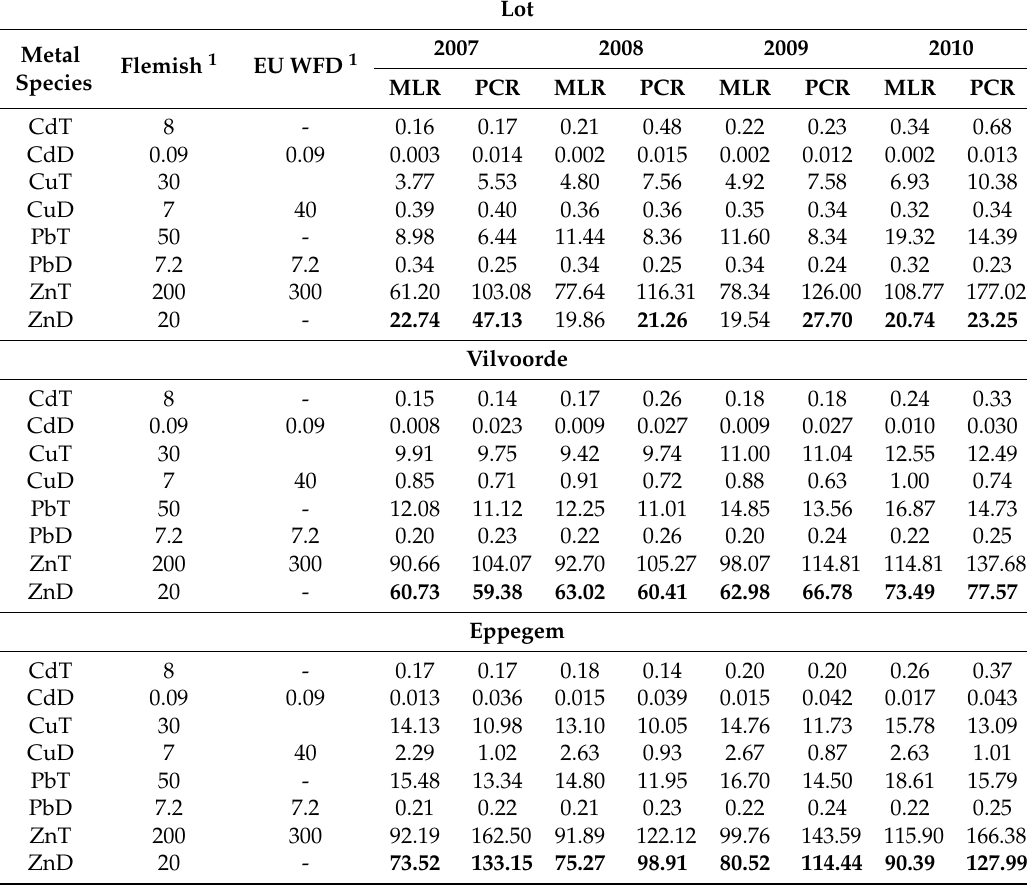
Table 6. Simulated yearly average concentration of different metal species at Lot, Vilvoorde and Eppegem and comparison with Flemish and European Union (EU) mandatory